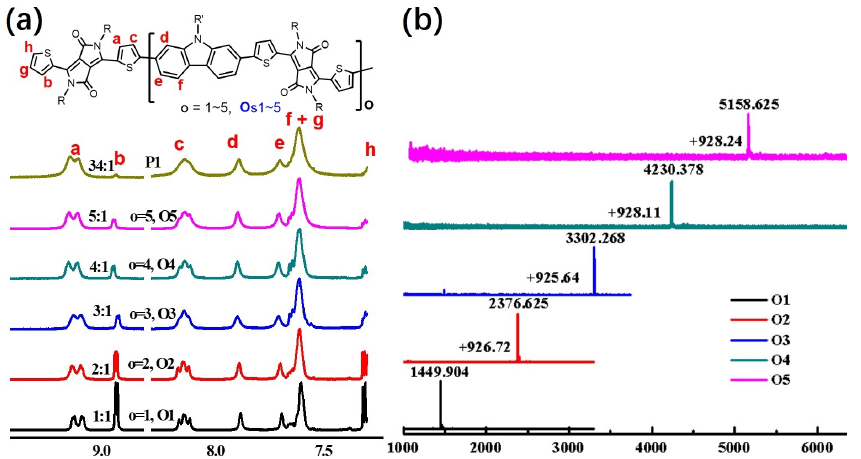
Figure 1. ( a ) 1 H NMR spectra of O s1~5 and P 1 in aromatic region; ( b ) MALDI-TOF MS spectra of O s1~5.